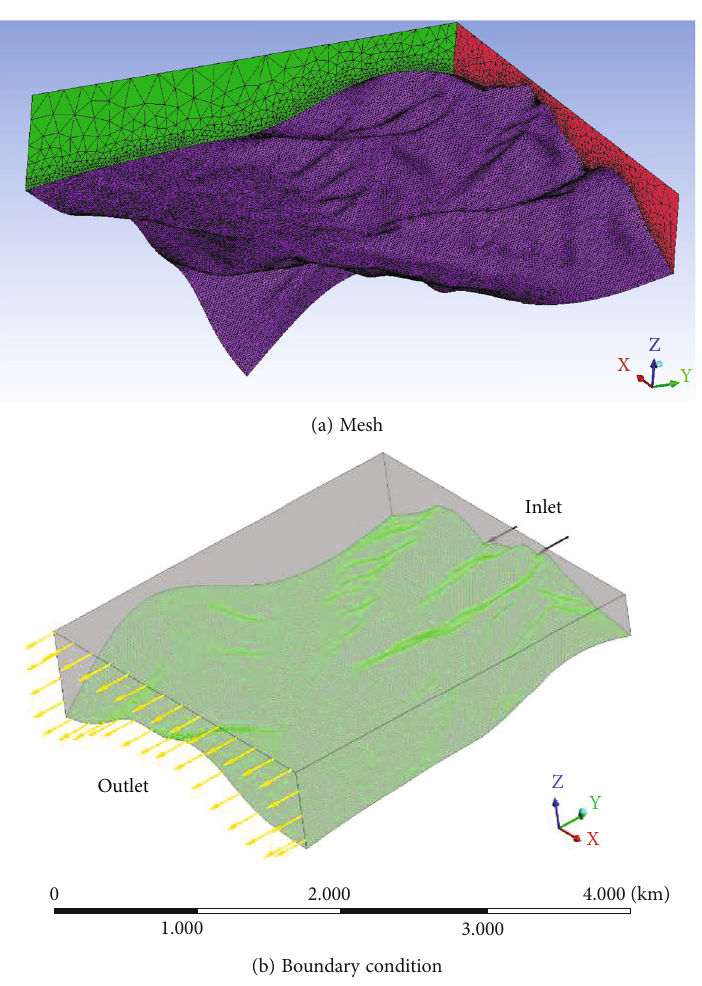
Figure 4: Model and meshing for numerical simulation of debris fl ow. Table 1: Calculation parameters of debris fl ow for